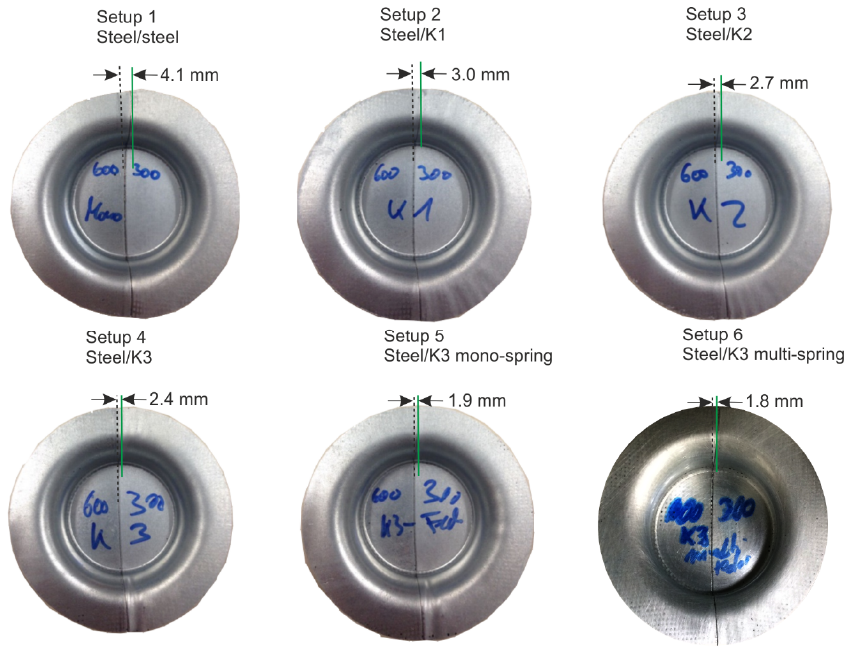
Figure 4. Formed cups in different die ‐ setups with distance of weld ‐ line movement (left side of TWB: DP600, right side: HX300LAD). DP600, right side: